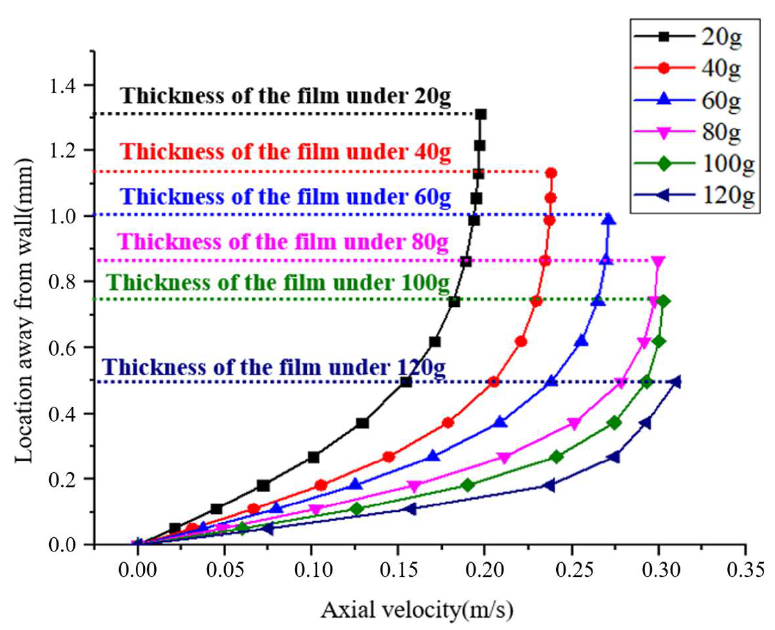
Figure 12. Thickness of the liquid film and the axial velocity distribution with different centrifugal acceleration.